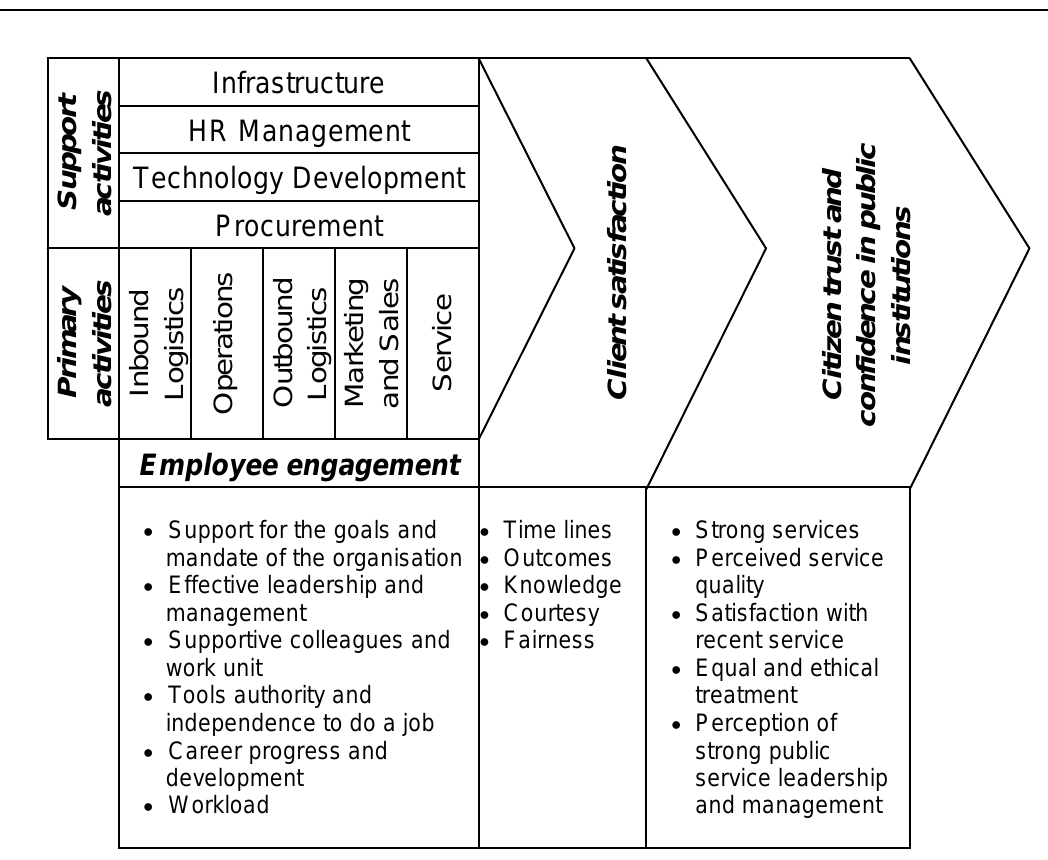
Figure 2: Porter’s value chain adopted for a public sector